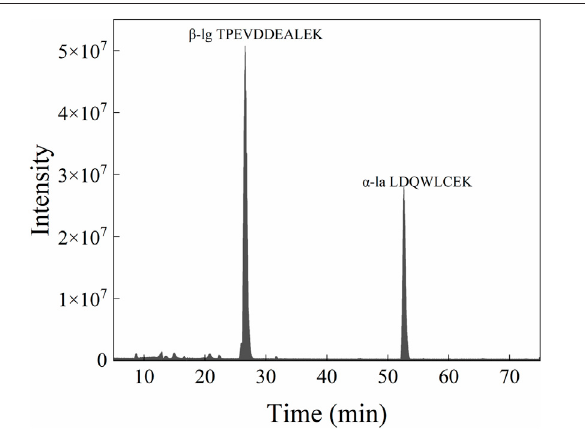
FIGURE 7 | Mass spectrometric analysis results of desalted whey powder with protein concentration of 0.2